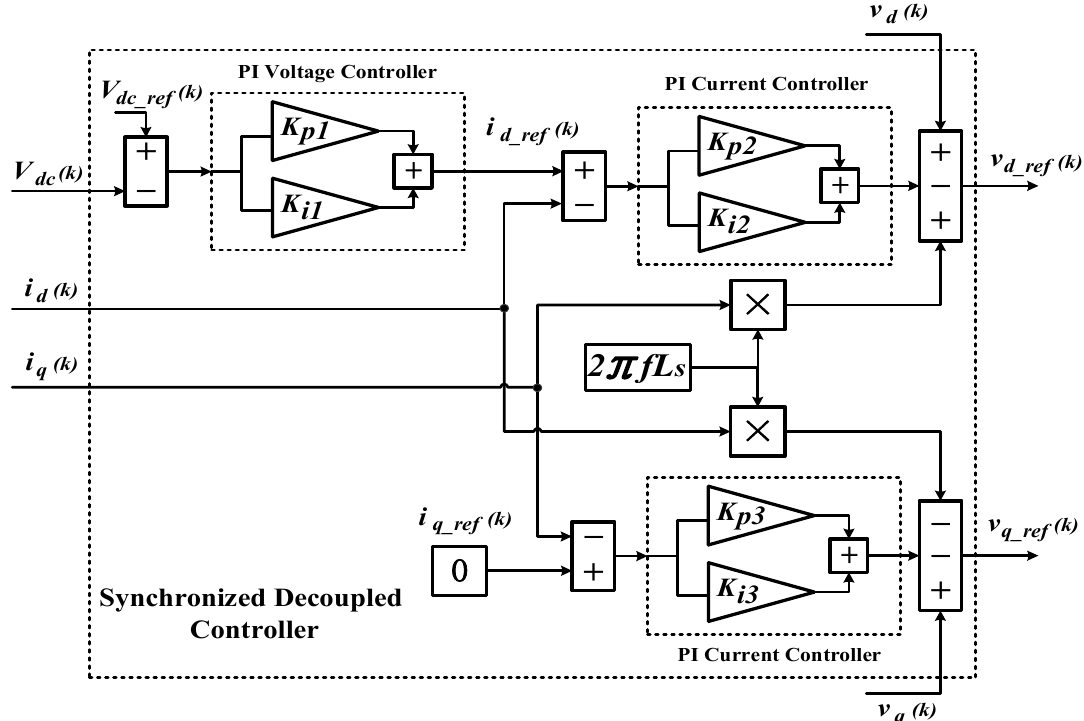
Figure 6. The block diagram of synchronized decoupled controller with three proportional integral (PI) controllers.